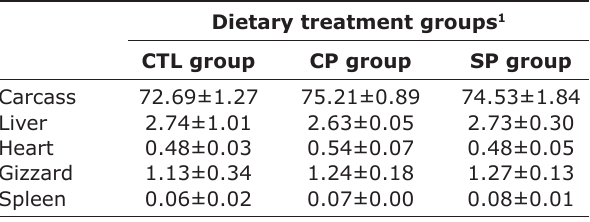
Figure-3: Feed conversion ratio of broilers fed basal diets supplemented with antibiotics (CTL group), commercial probiotic Protexin ® (CP group), and study probiotic mixture (SP group). Values are the FCR at every 4 th days’ interval. Within each day, different letters indicate significant difference in values at p < 0.05 (ANOVA, Duncan’s Table-2: Effects of dietary probiotic treatments on internal organs weight relative to body weights of broiler chickens (percentages).